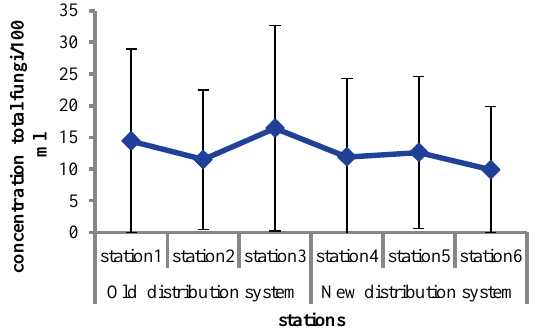
Figure 3. The average and standard deviation concentration of fungi (CFU/100 ml), in water of two distribution networks CFU: Colony forming unit